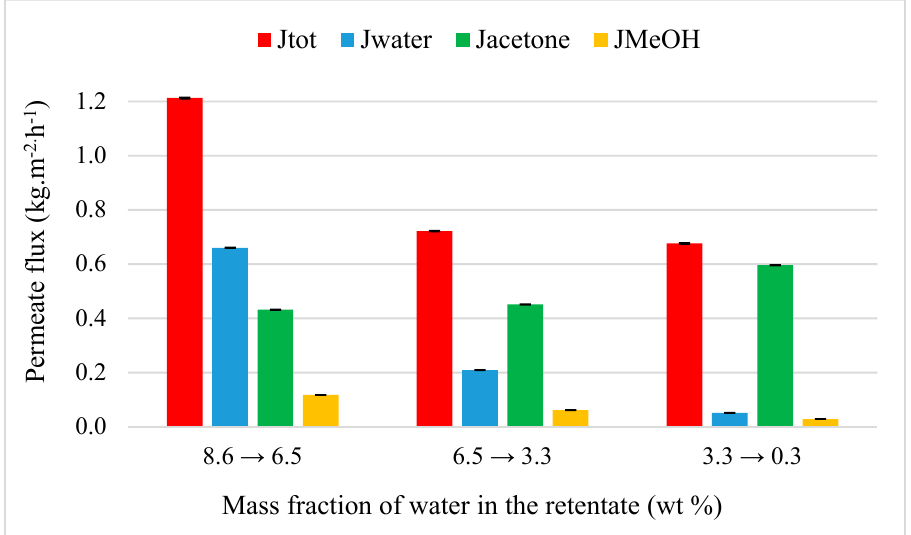
Figure 8. Evolution of flux as the function of the inlet water composition from a ternary